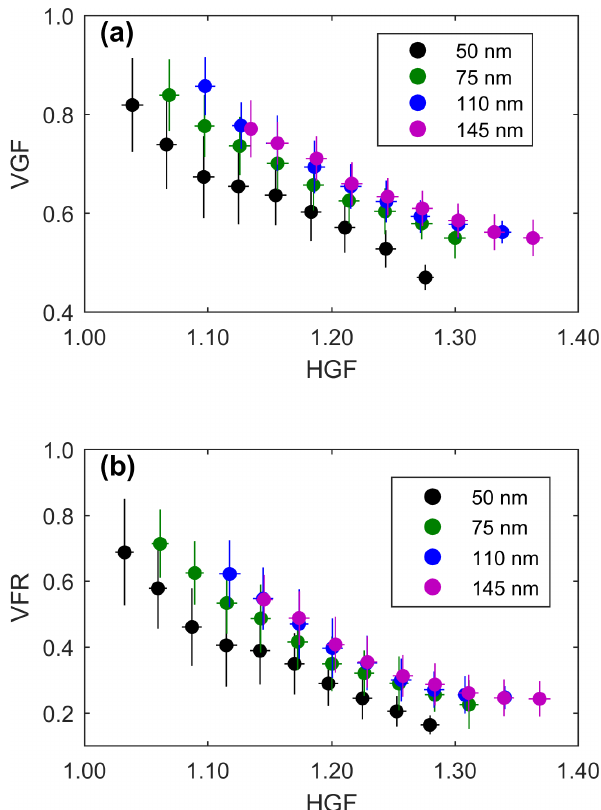
Figure 7. Relationship between the mean hygroscopic growth fac- tors (HGFs) and the conjugate volatility growth factors (VGFs; a ), and between the HGFs and the conjugate volume fraction remaining (VFR) after the thermal treatment (b) obtained at a mean relative humidity and at a mean temperature of 90% and 270 ◦ C, respec- tively, for different dry particle diameters. The error bars indicate ±